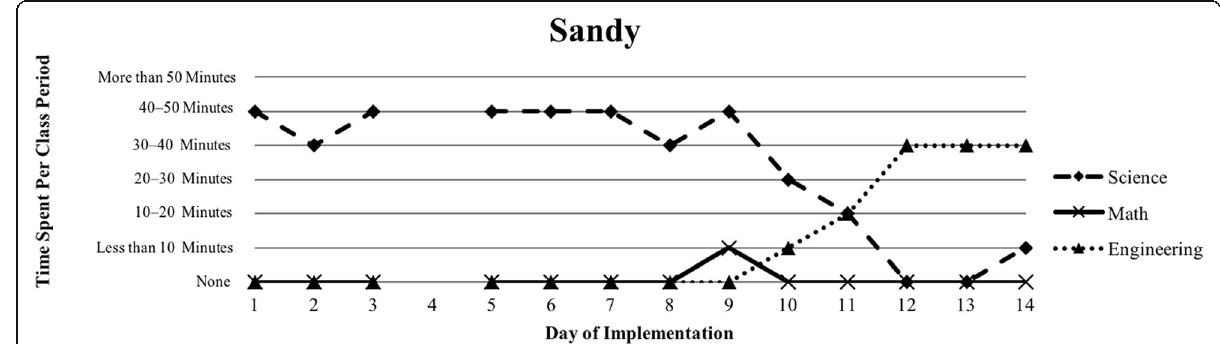
Fig. 1 Sandy ’ s implementation of Heat Transfer 1 in her 8th grade science class